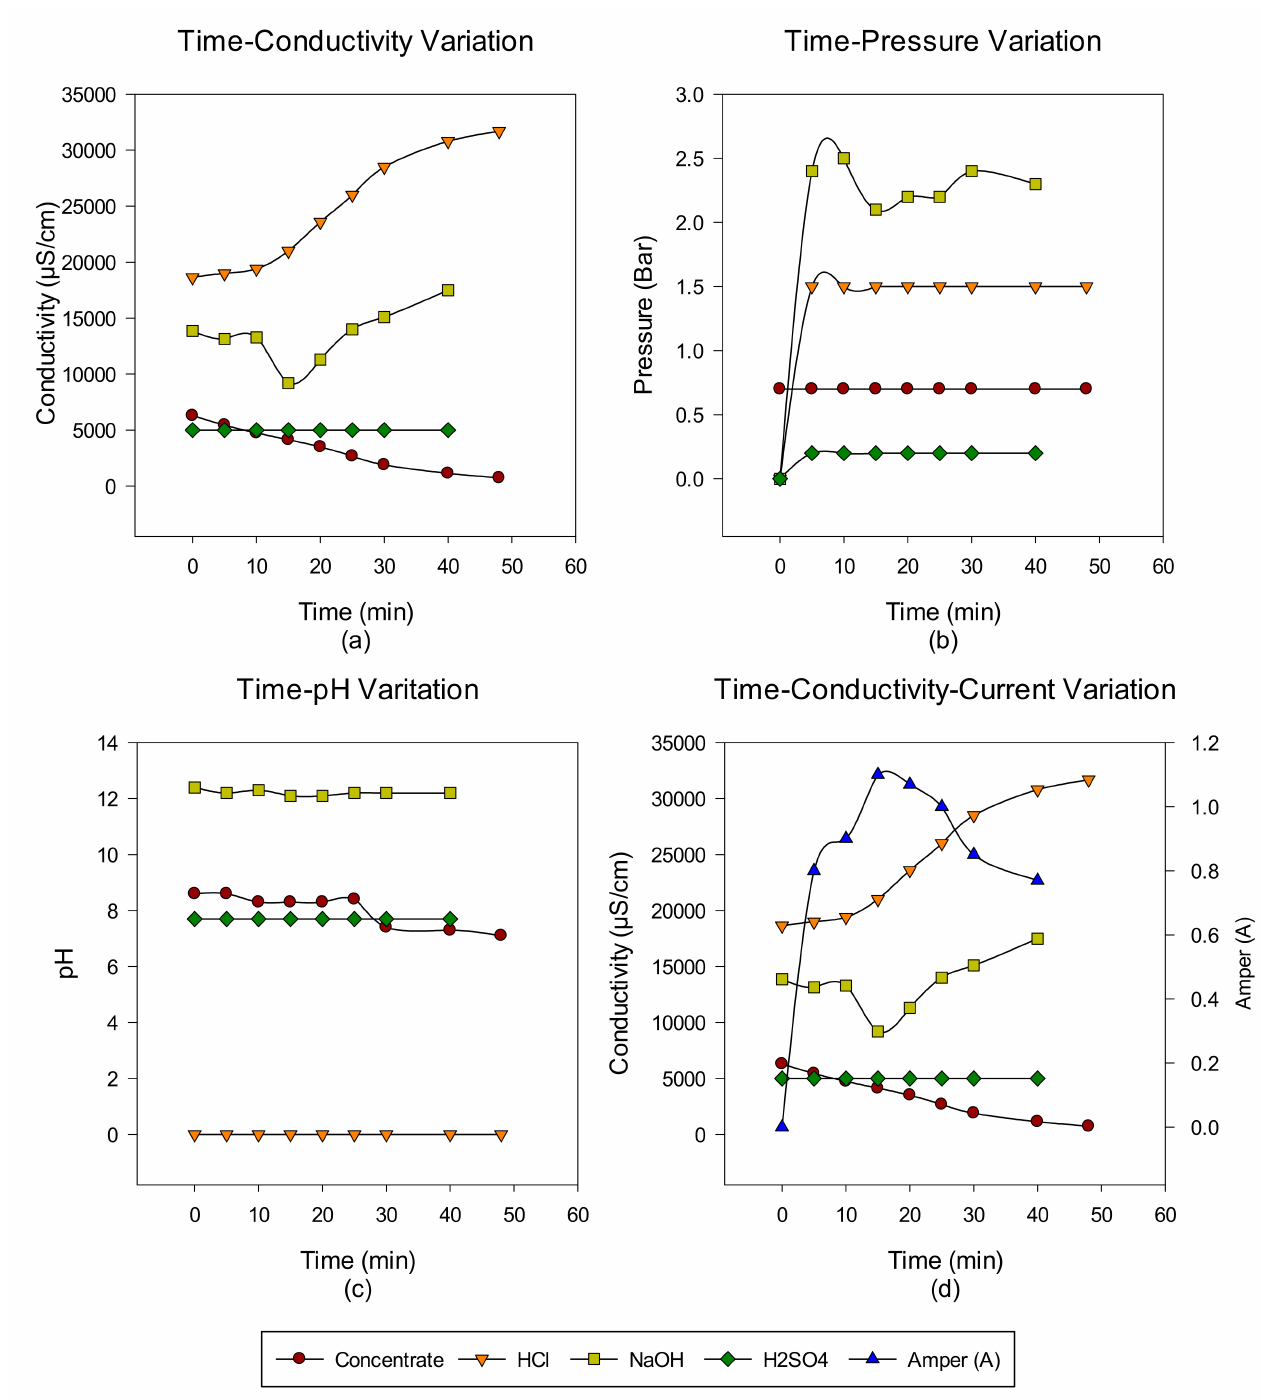
Figure 4. Between 0 and 48 min, NaCl–NaOH–HCl–Na 2 SO 4 ( a ) conductivity, ( b ) pressure, ( c ) pH, and ( d ) conductivity and ampere